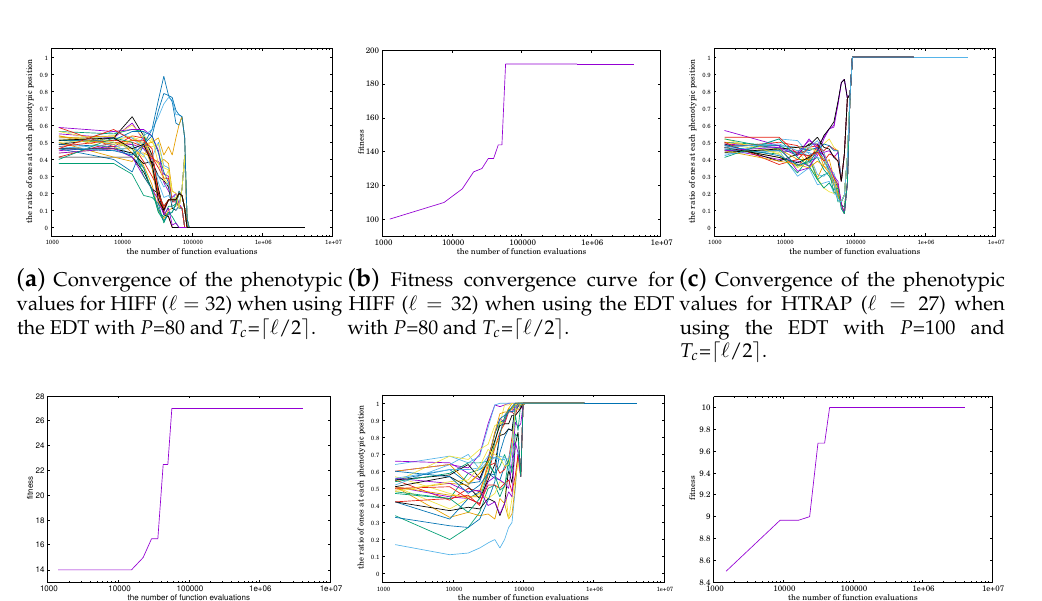
( e ) Convergence of the phenotypic values for HDEP ( (cid:96) = 30) when using the EDT with P =100 and T c = (cid:100) (cid:96) /2 (cid:101) .